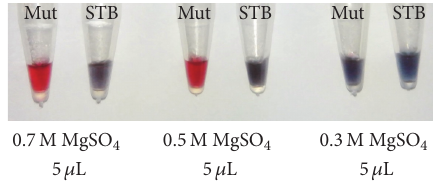
Figure 4: Determining the optimal concentration of MgSO 4 for detection by colorimetric assay.